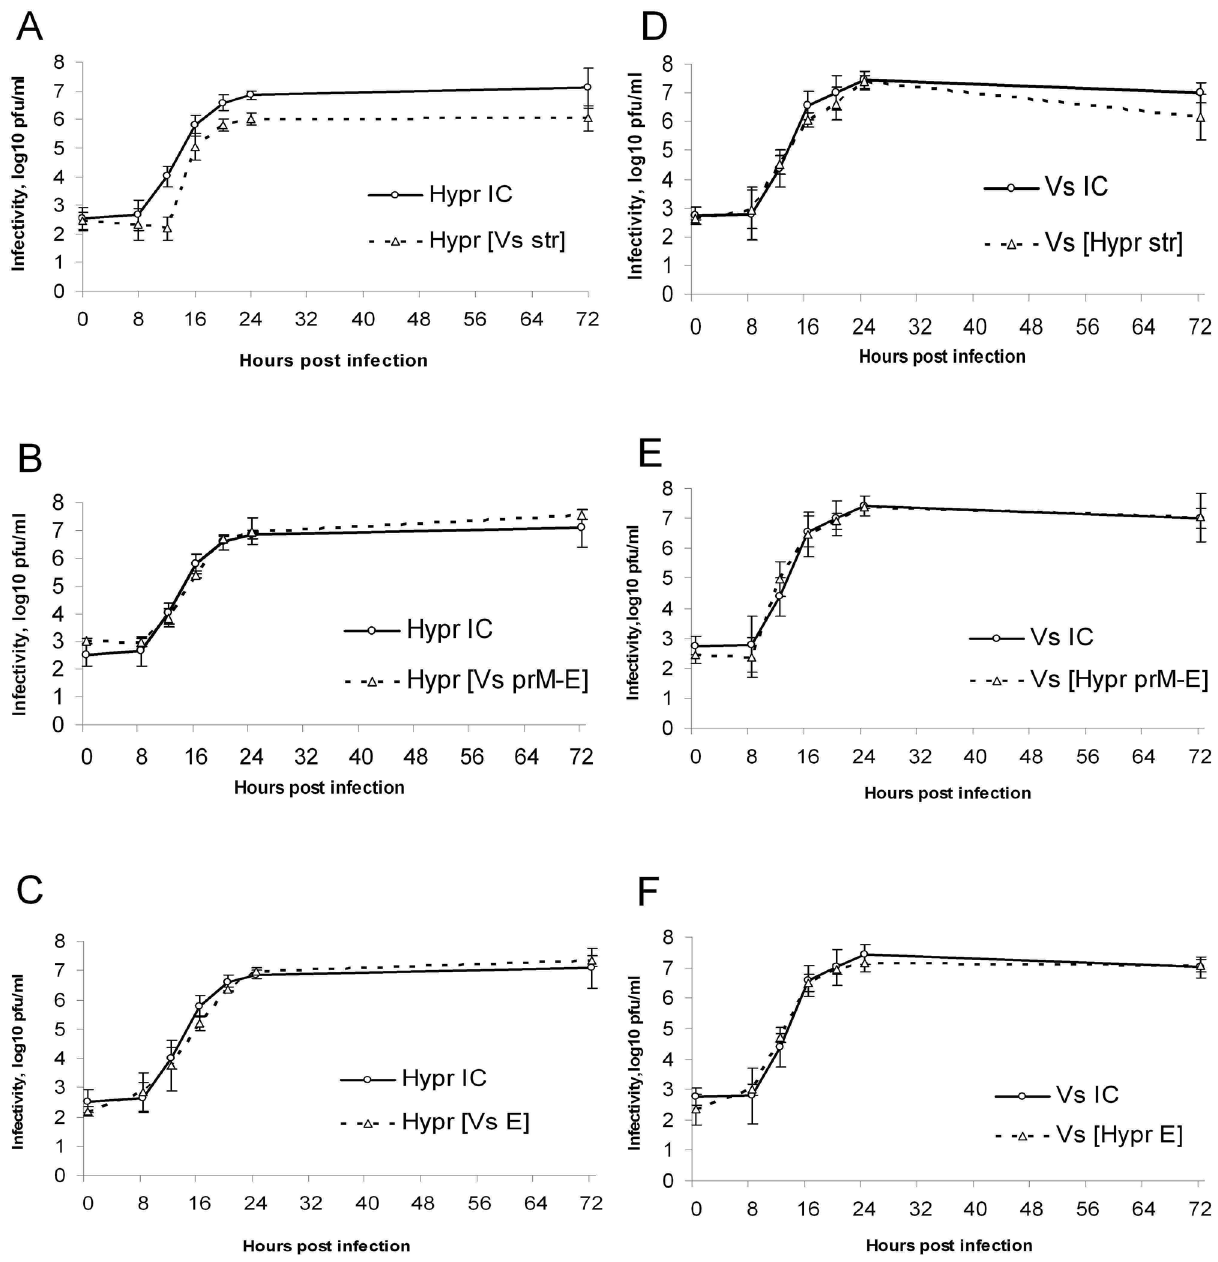
Fig 3. Chimaeric virus growth kinetics in cell culture. Viruses are specified as shown in the text. PS cells were infected with TBEV at a multiplicity of 1 pfu per cell in at least 4 replicates. Samples of cell culture media were collected every 4 hours during the first day pi and then once a day. Virus infectivity was established by plaque assay. A-C) HyprIC and Hypr-based recombinant viruses; D-F) VsIC and Vs-based recombinant viruses. Error bars reflect 95% confidence